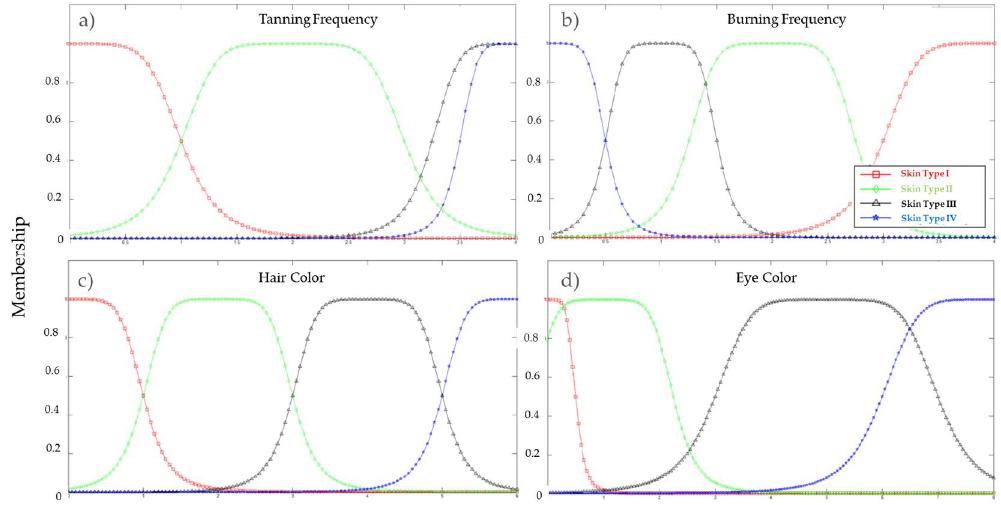
Figure 3. The fuzzy membership functions for tanning frequency ( a ), sun burning frequency ( b ), hair color ( c ) and eye color ( d ), for skin types I, II, III and IV, with red, green, blue and black, respectively.